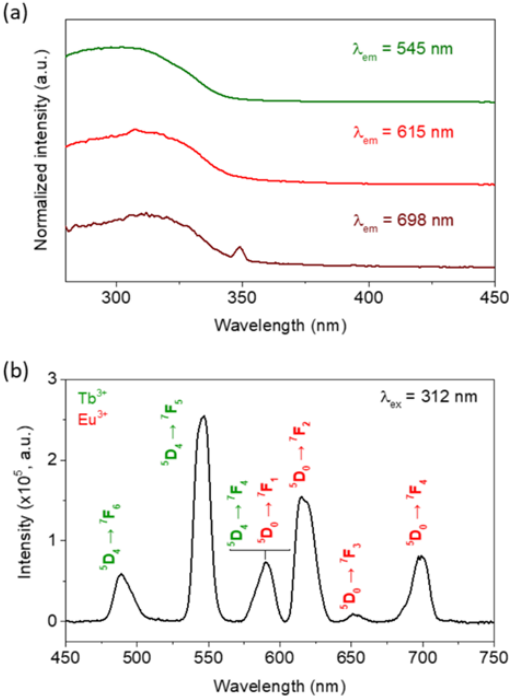
Figure 5. ( a ) Room temperature excitation spectra of IONP@SiO 2 - acac /Tb 3+ /Eu 3+ monitored at λ em = 545, 615, and 698 nm. ( b ) Room temperature emission spectrum performed with λ ex = 312 nm for IONP@SiO 2 - acac /Tb 3+ /Eu 3+ . The Eu 3+ and Tb 3+ based transitions are written in red and green, respec- tively.